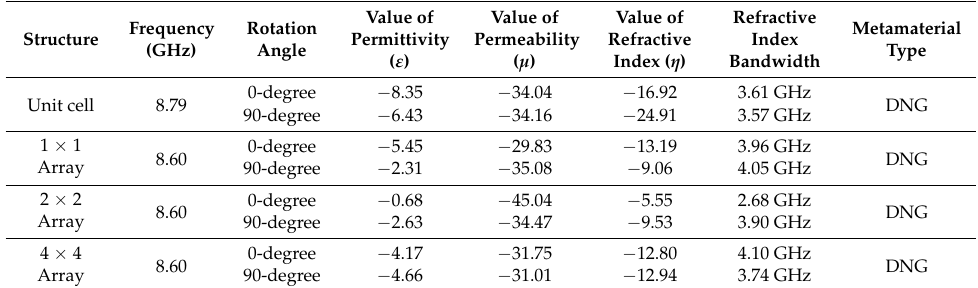
Table 2. Real values of ε , µ , and η in the resonance frequency band for the unit cell and array configuration at 0-degree and 90-degree rotation.